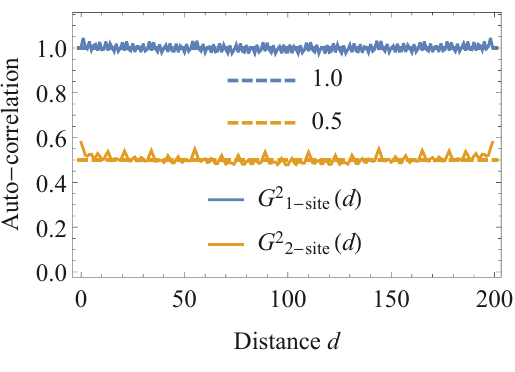
Figure 13 . Auto-correlation of the disorder vector g for the { 3 , 7 } MTN at the critical Ising point between 1 - and 2 -site blocks at distance 0 ≤ d ≤ N/ 3 , for a boundary system of N = 597 sites. Both auto-correlations are independent of d up to small